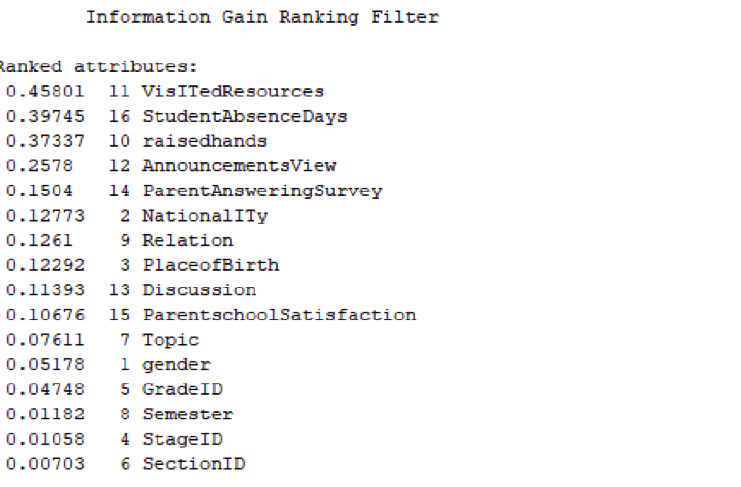
Figure 4. Information gain